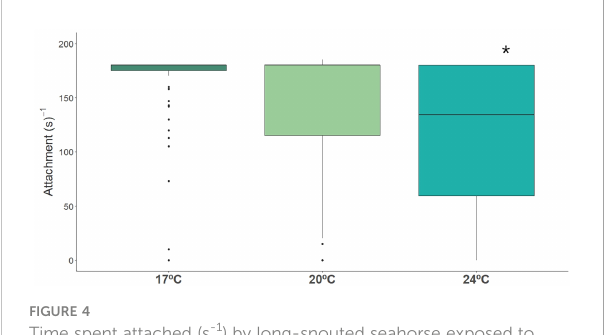
FIGURE 6 Impact of ocean warming on weight gain (%) of long-snouted seahorse exposed to different temperature treatments (17°C, 20°C and